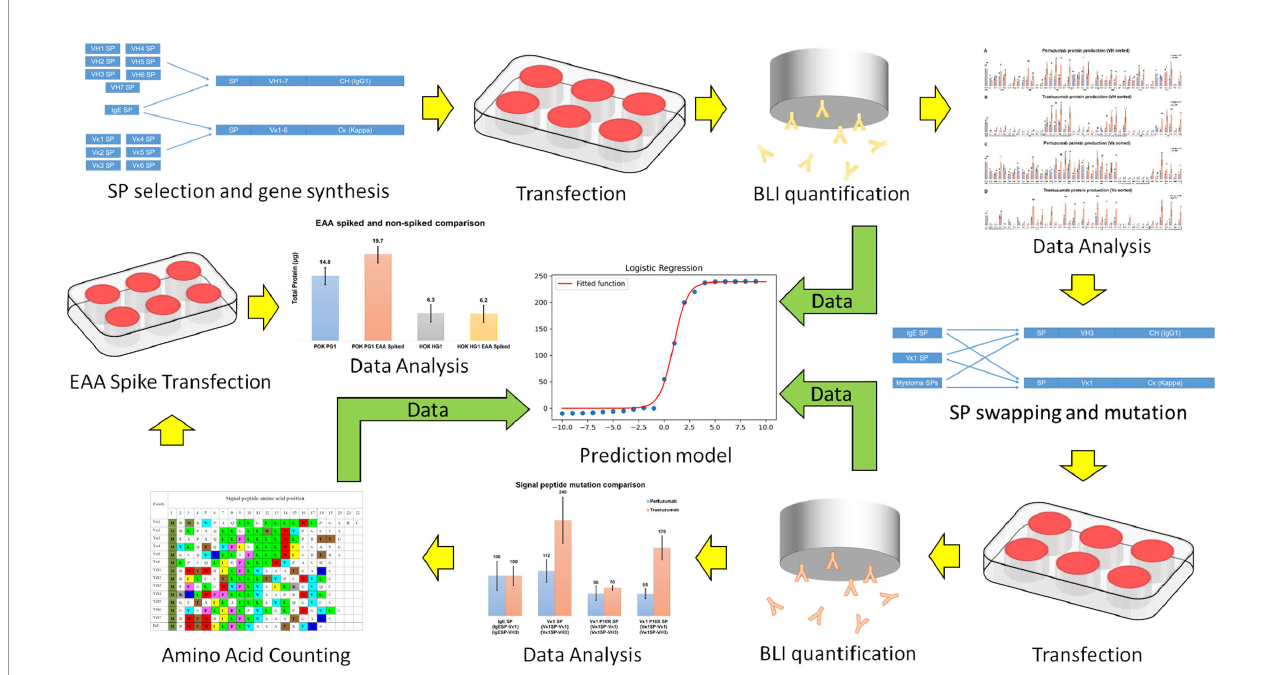
FIGURE 1 | A schematic of work fl ow in the present study. Yellow arrows indicate experiment sequences while green arrows indicate data fl ow for constructing the predictive